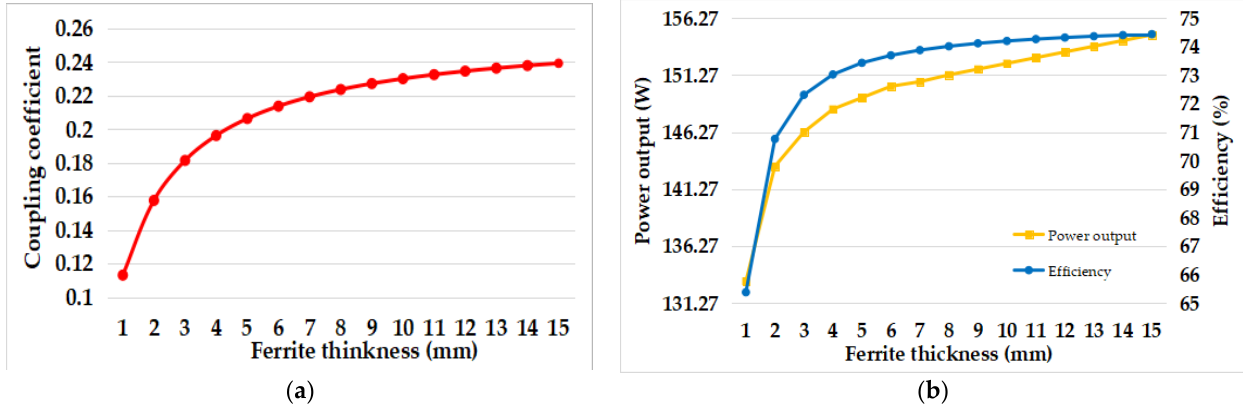
Figure 6. Coupling performance and system outputs with different thickness of ferrite: ( a ) Coupling coefficient versus ferrite thickness; ( b ) Power output and system efficiency versus ferrite thickness.